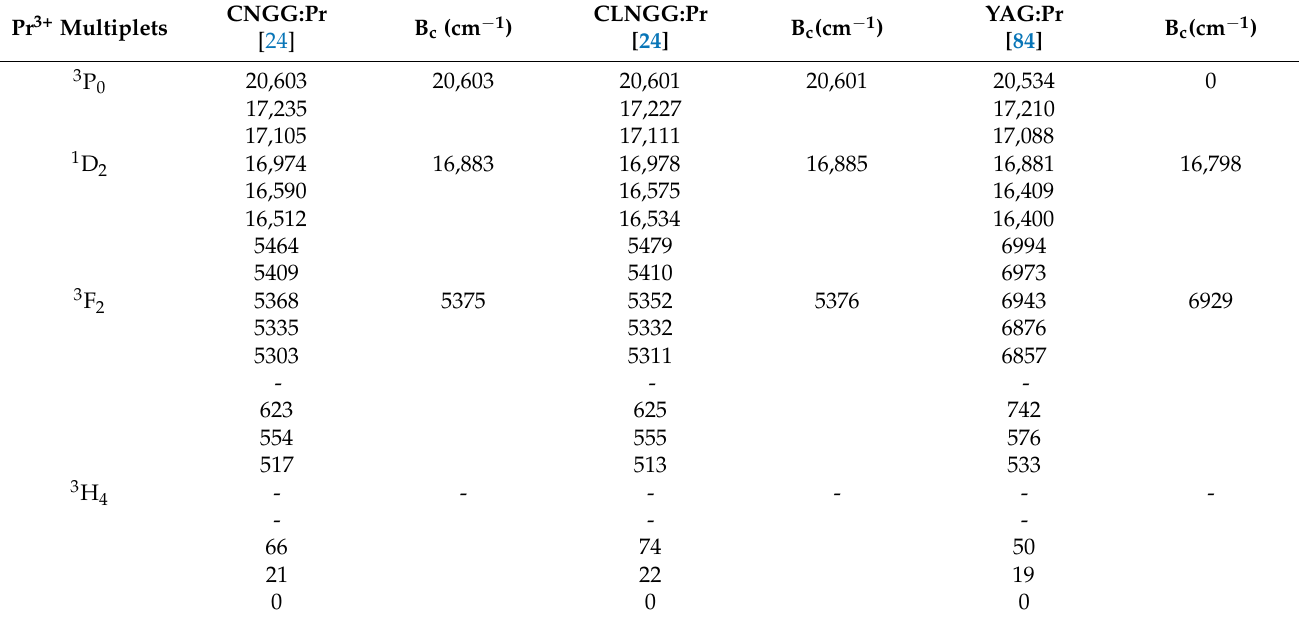
Table 13. Energy levels of Pr 3+ ions involved in the 3 P 0 → 3 H 4 , 1 D 2 → 3 H 4 , and 3 P 0 → 3 F 2 emission transitions in CNGG:Pr and CLNGG:Pr